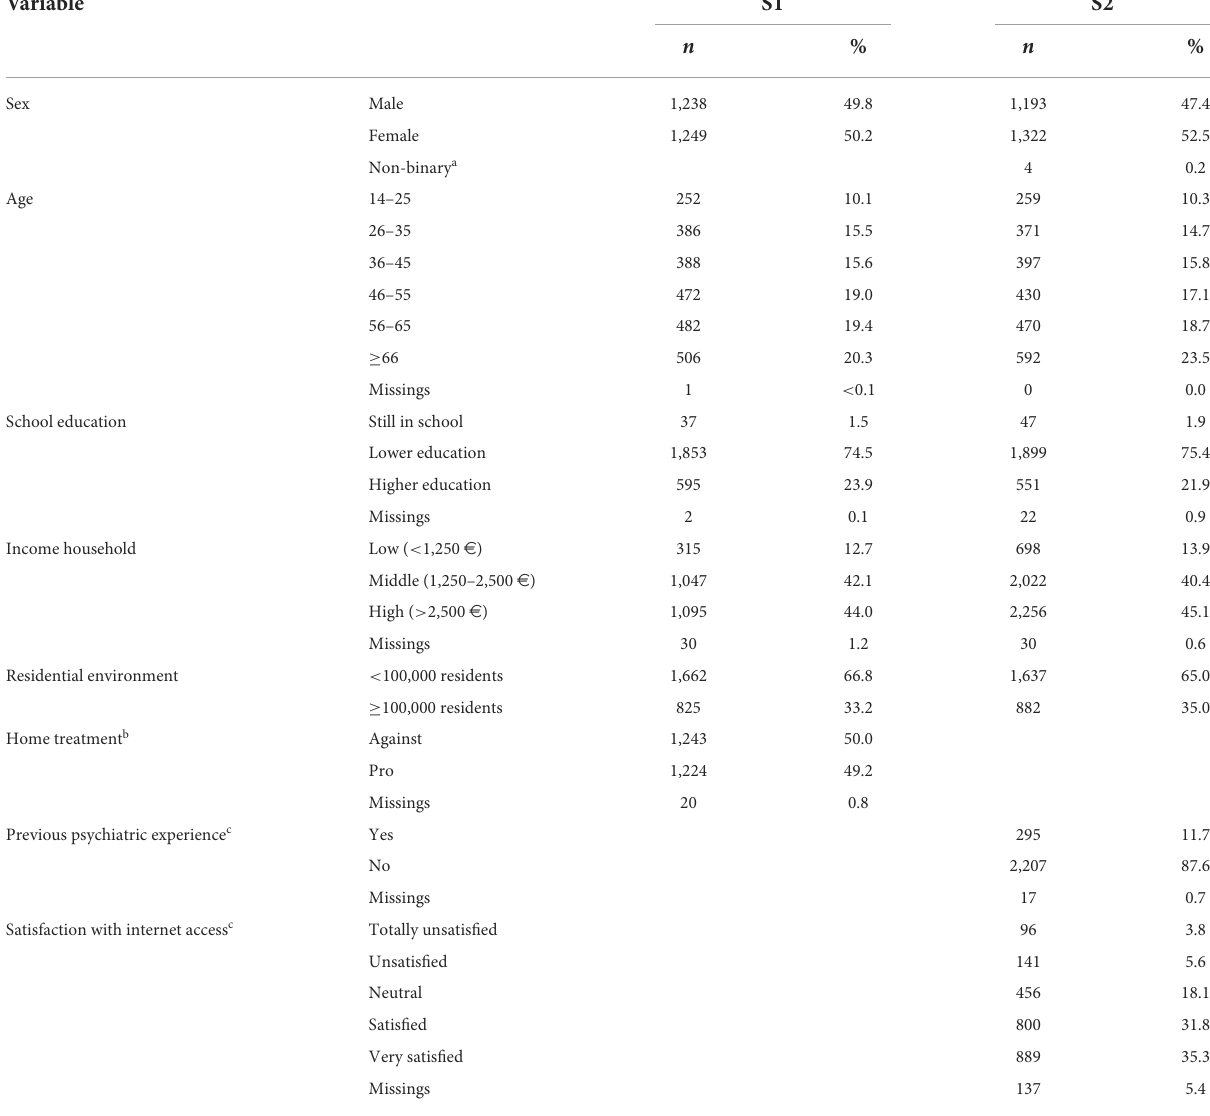
TABLE 1 Sociodemographic characteristics and response frequencies on other relevant items of the two study samples.